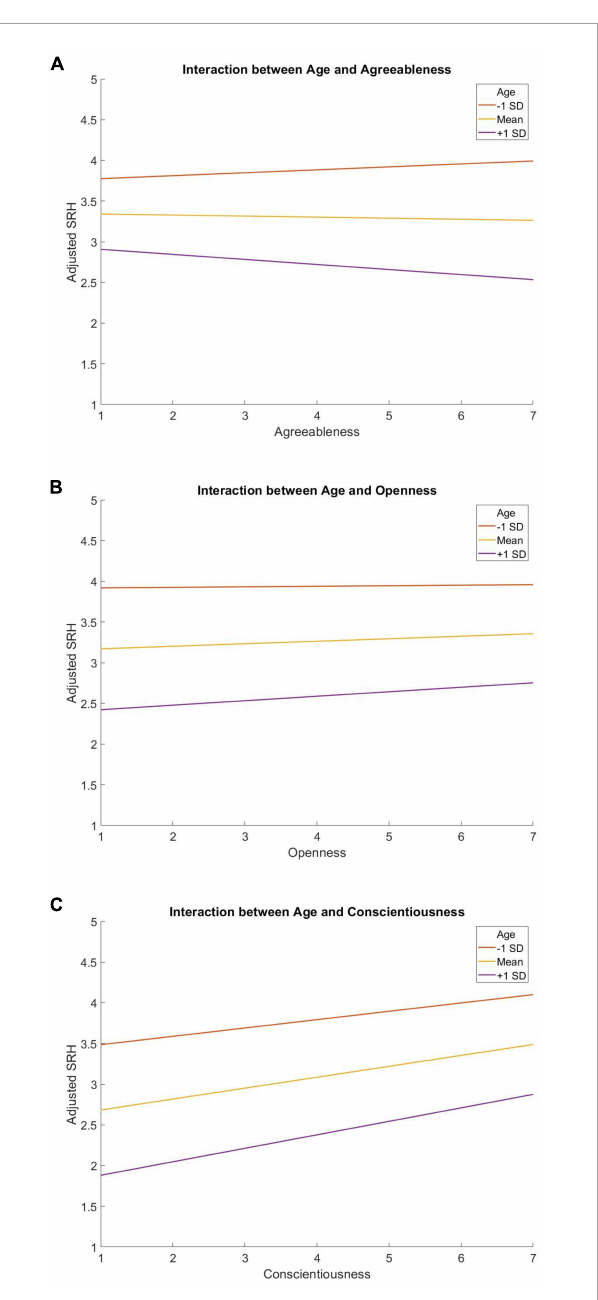
FIGURE1 The moderating role of age on the associations between Agreeableness (A) , Openness (B) , Conscientiousness (C) , and SRH.